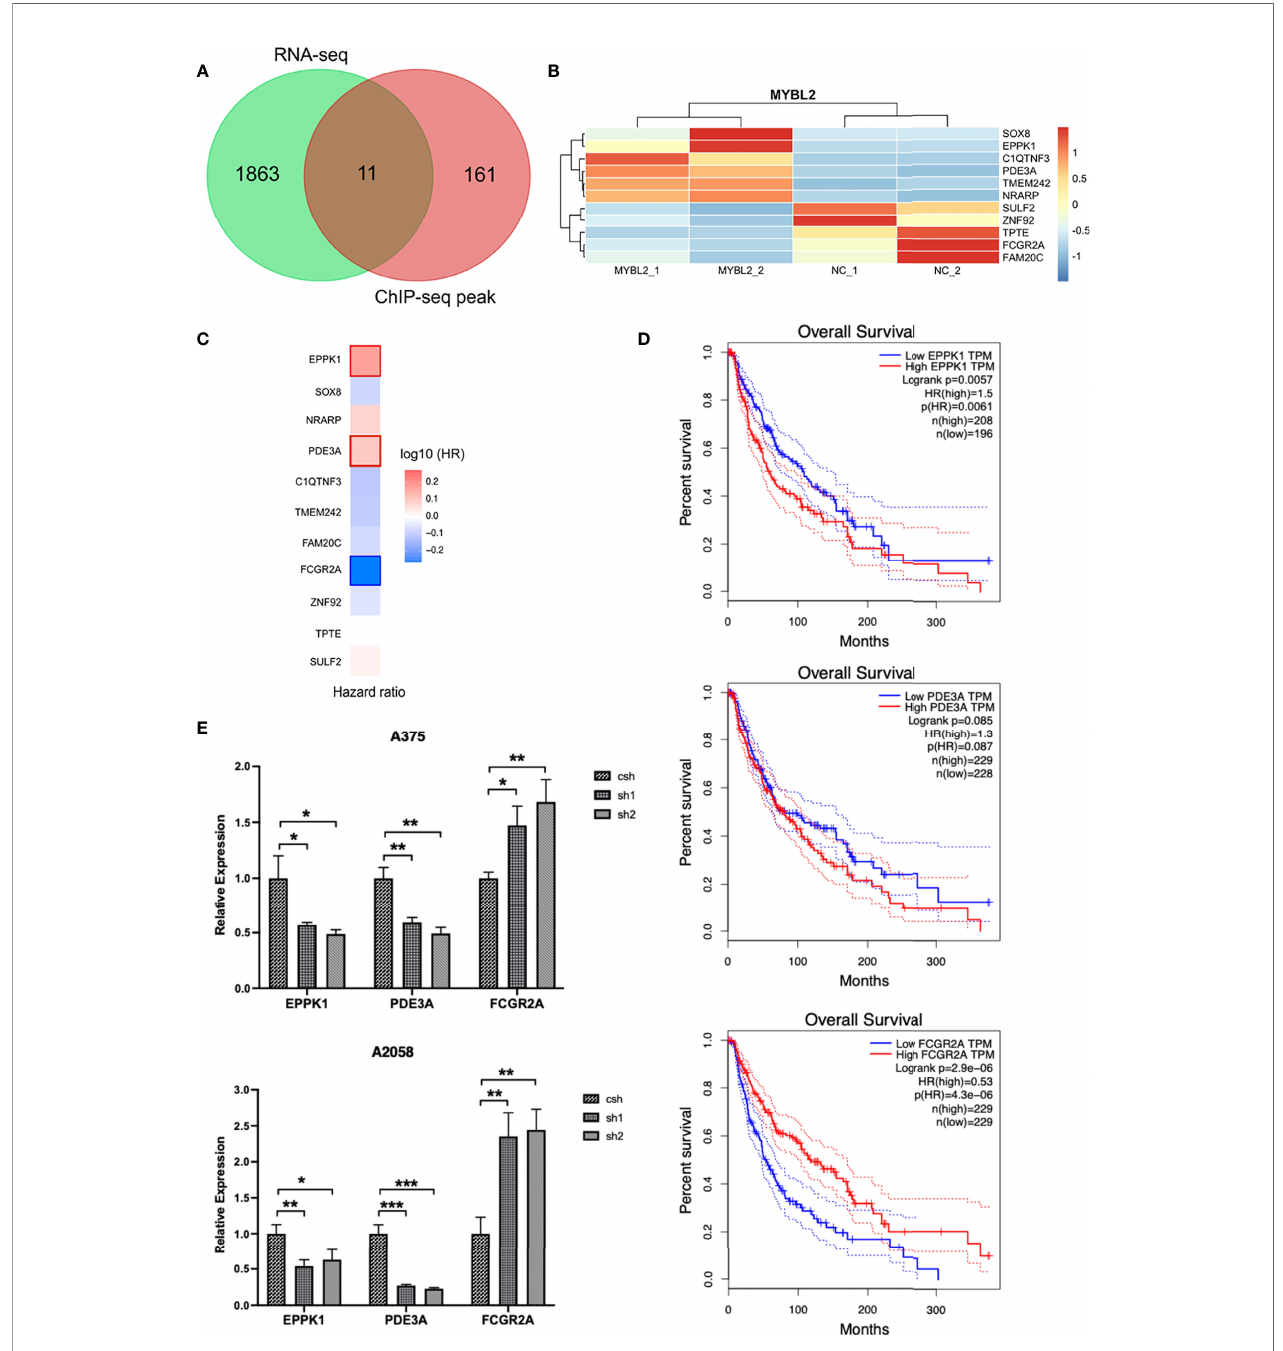
FIGURE 7 | Combined transcriptome pro fi ling and ChIP-Seq analysis identi fi es 3 highly plausible direct targets of MYBL2. (A) Venn diagram showing the overlap of genes among RNA-Seq differentially expressed genes (DEGs) and ChIP-Seq peak. (B) Heatmap of 11 signi fi cantly DEGs. The data form the transcription pro fi ling of A2058 with overexpressed MYBL2. (C) Multivariate Cox regression analysis of 3 signi fi cant genes ( EPPK1, PDE3A , and FCGR2A ). (D) Survival curve of 3 signi fi cant differential genes ( EPPK1, PDE3A , and FCGR2A ) using Kaplan – Meier curve analysis in melanoma patients. (E) Relative expression levels of MYBL2 target genes ( EPPK1, PDE3A , and FCGR2A ) in A375 and A2058 cells infected with MYBL2 ‐ shRNAs lentiviruses compared with scrambled shRNA lentiviruses. * p < 0.05, ** p < 0.01, *** p <